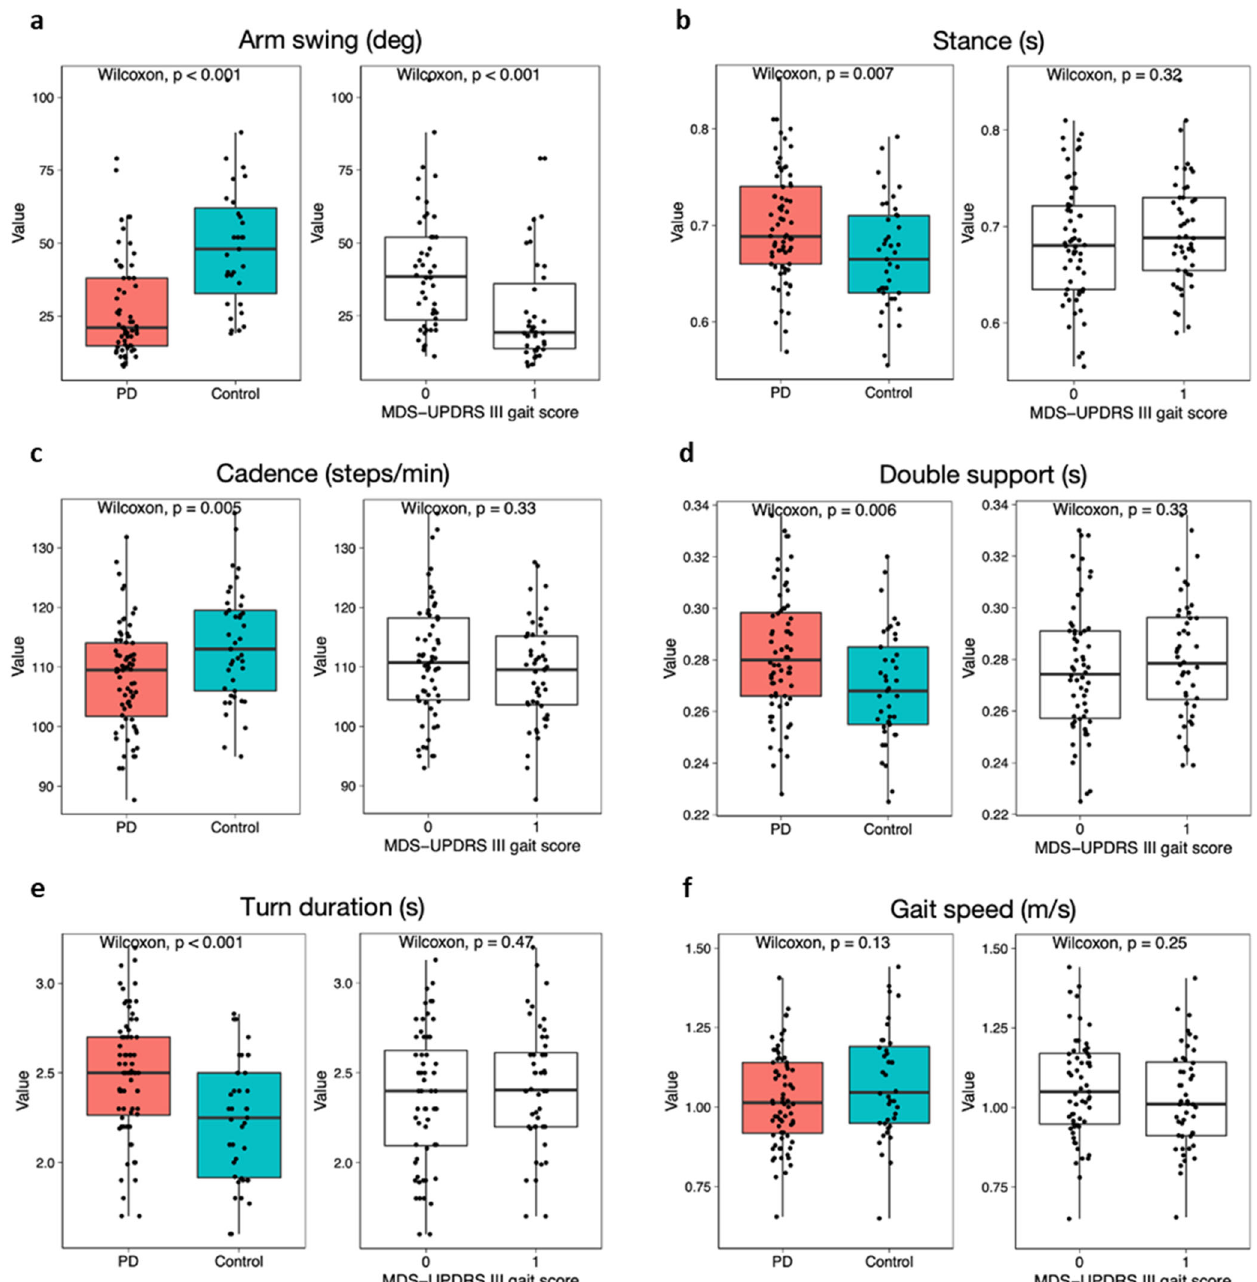
Fig. 1 Comparisons of gait features derived from a smartphone and smartwatch. Box plots for (panel a ) Arm swing (deg), (panel b ) Stance (s), (panel c ) Cadence (steps/min), (panel d ) Double support (s), (panel e ) Turn duration (s), and (panel f ) Gait speed (m/s) between those with and without Parkinson ’ s disease and by MDS-UPDRS part III gait item 3.10. MDS-UPDRS Movement Disorder Society-Uni fi ed Parkinson ’ s Disease Rating